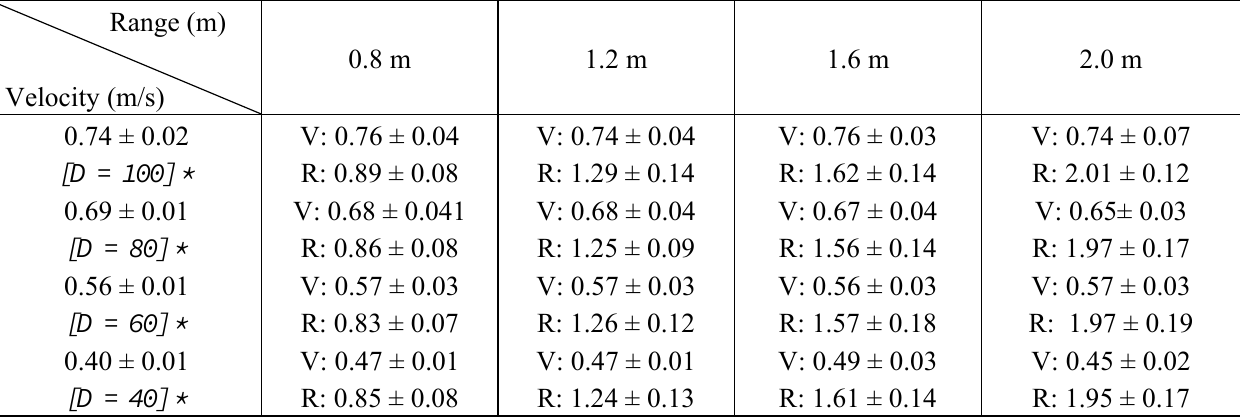
Table 4. Velocity (V) and Range (R) estimation from Doppler radar